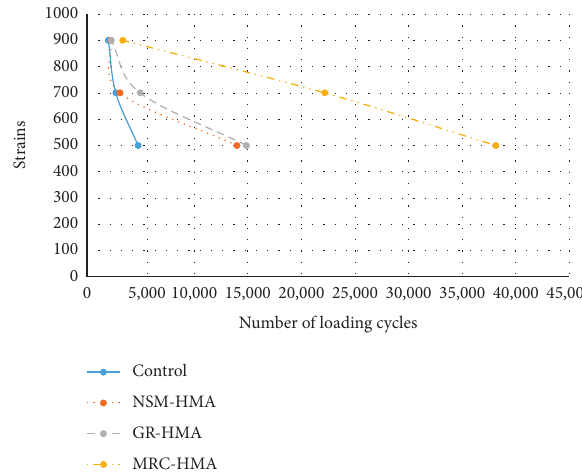
Figure 5: Comparison of the fatigue curves of control, NSM-HMA, GR-HMA, and MRC-HMA